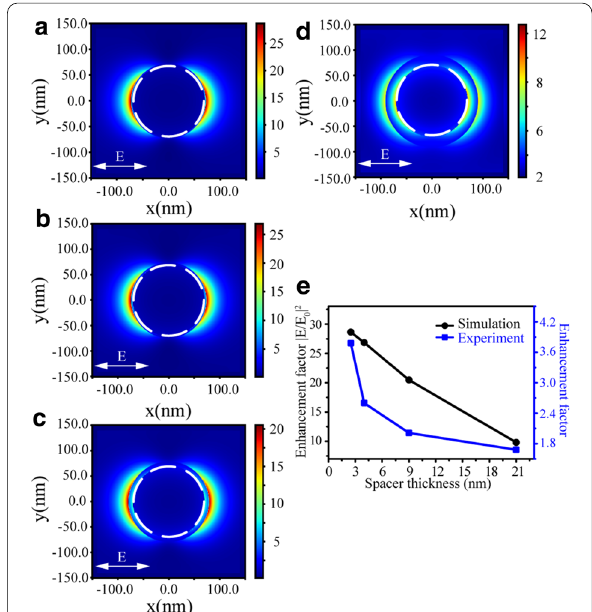
Fig. 5 Electric field enhancement (| E / E 0 | 2 ) distribution images for Au NPs covered with PMMA at λ 562 nm with the spacer thickness = 2.5 nm ( a ), 4 nm ( b ), 9 nm ( c ) and 21 nm ( d ), while the dashed white circle represents Au NP. e The enhancement factors of the experimental fluorescence spectra (blue) and the simulated electric field (black) dependent on the PMMA spacer